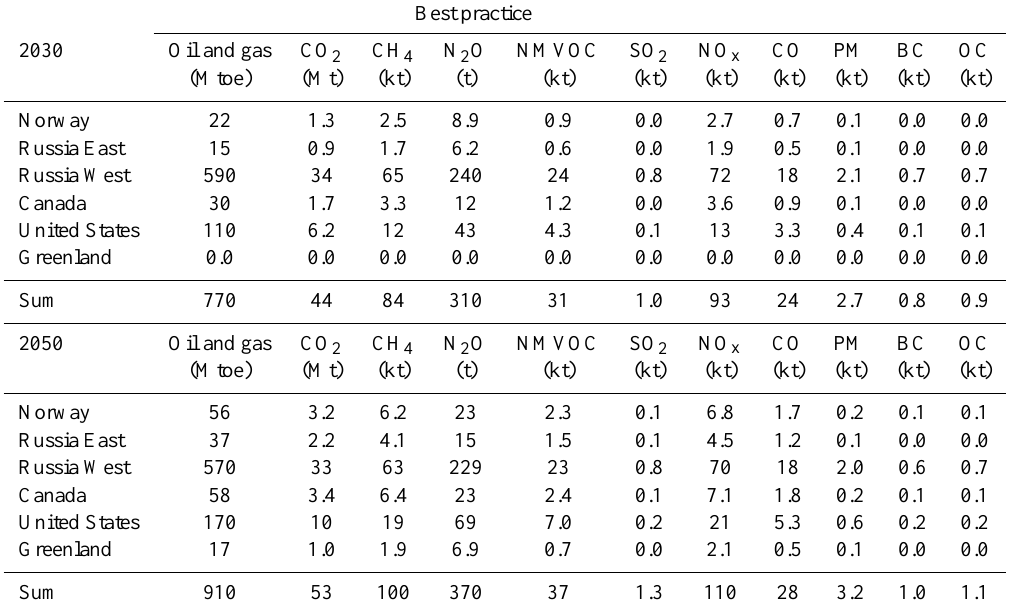
Table 3. Estimated emissions from oil and gas extraction in the Arctic assuming 2004 Best Practice emission factors in each year. Best